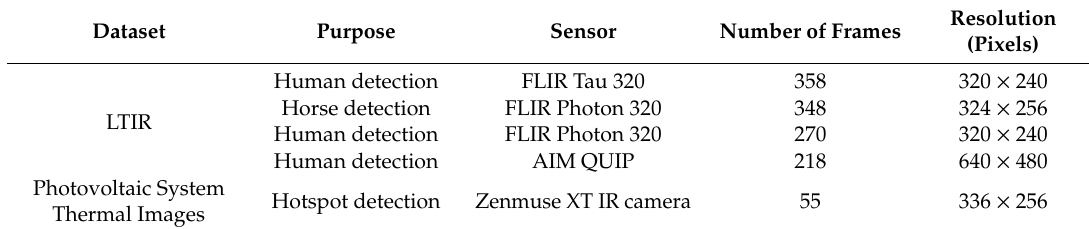
Table 2. List of the infrared image